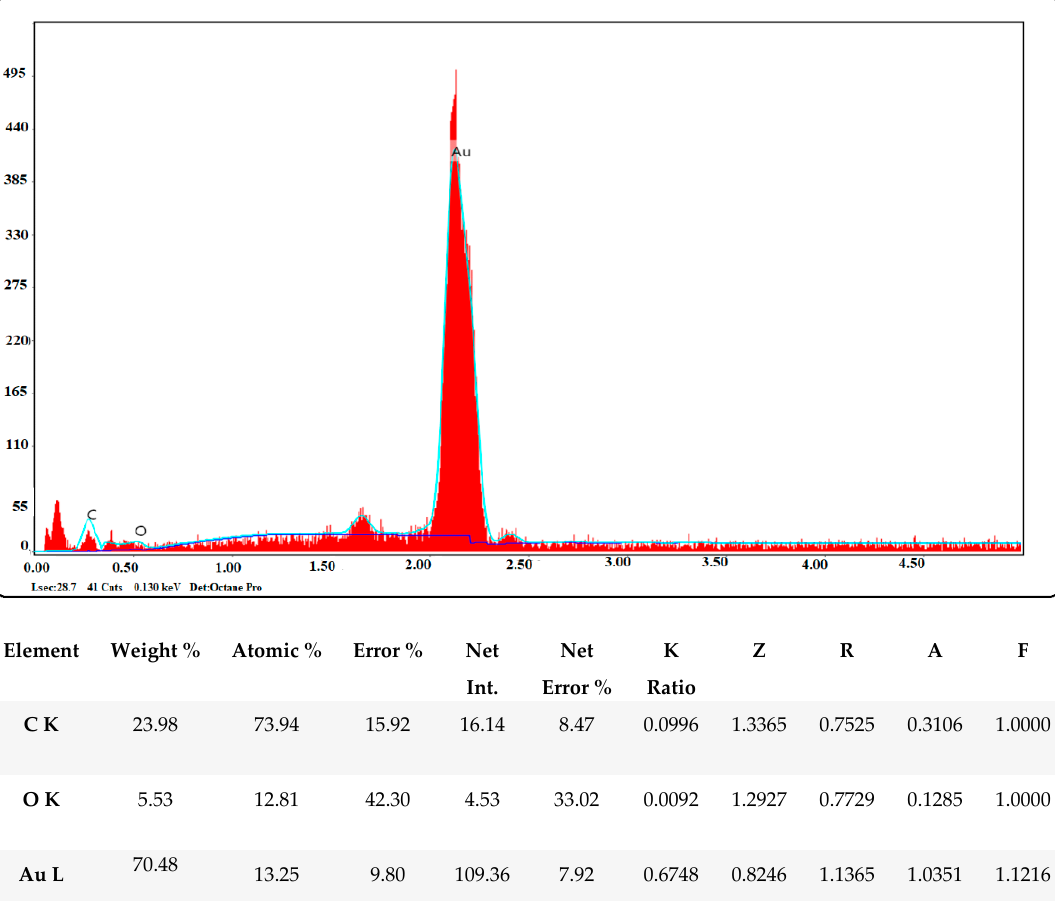
Figure 6. Morphological structures of the synthesized AC-AuNPs; ( a ) TEM, and ( b ) FESEM micro- graph images. 2.2.6. Surface Charge and Size Distributions of Synthesized AC-AuNPs